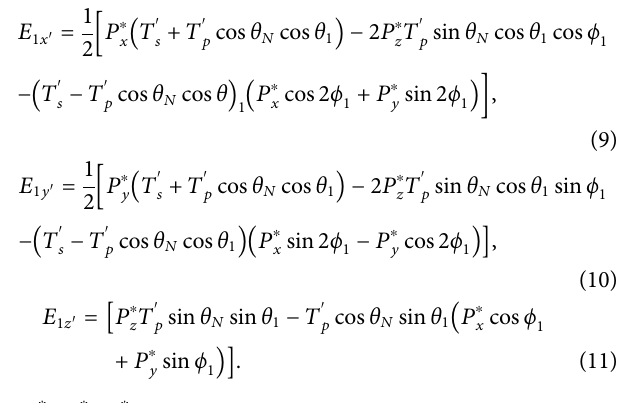
and Varga (1997). ψ i denotes the initial aberration function. Figure 1B shows the near-focus excitation intensity distributions at different depths.